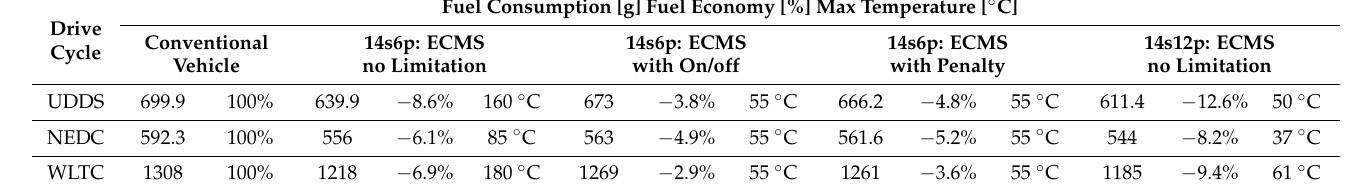
Table 3. Main results of the